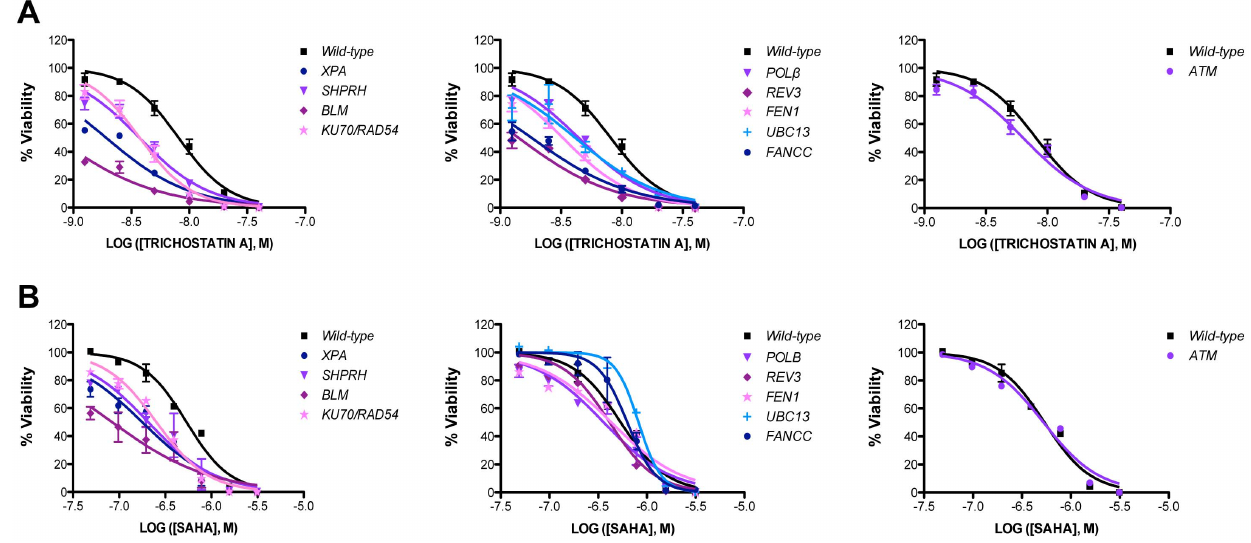
Figure 2. Viability of isogenic chicken DT40 B lymphocyte cell lines following 48 hr treatment with (A) 0 to 0.04 m M TSA and (B) 0 to 3.125 m M SAHA. Viability was determined using CellTiter-Glo. The data represent the average of 3 independent experiments 6 SD.